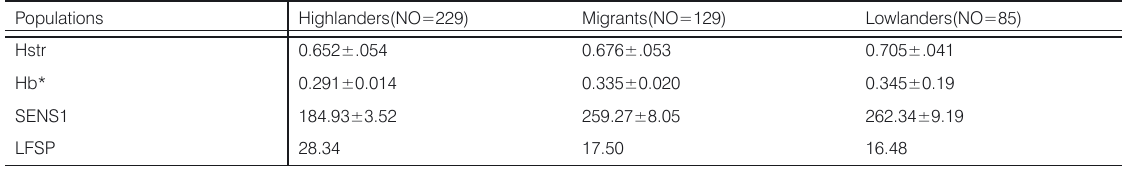
Table 5. Differences between Highlanders, Migrants and Lowlanders in Genetic and Demographic Parameters.